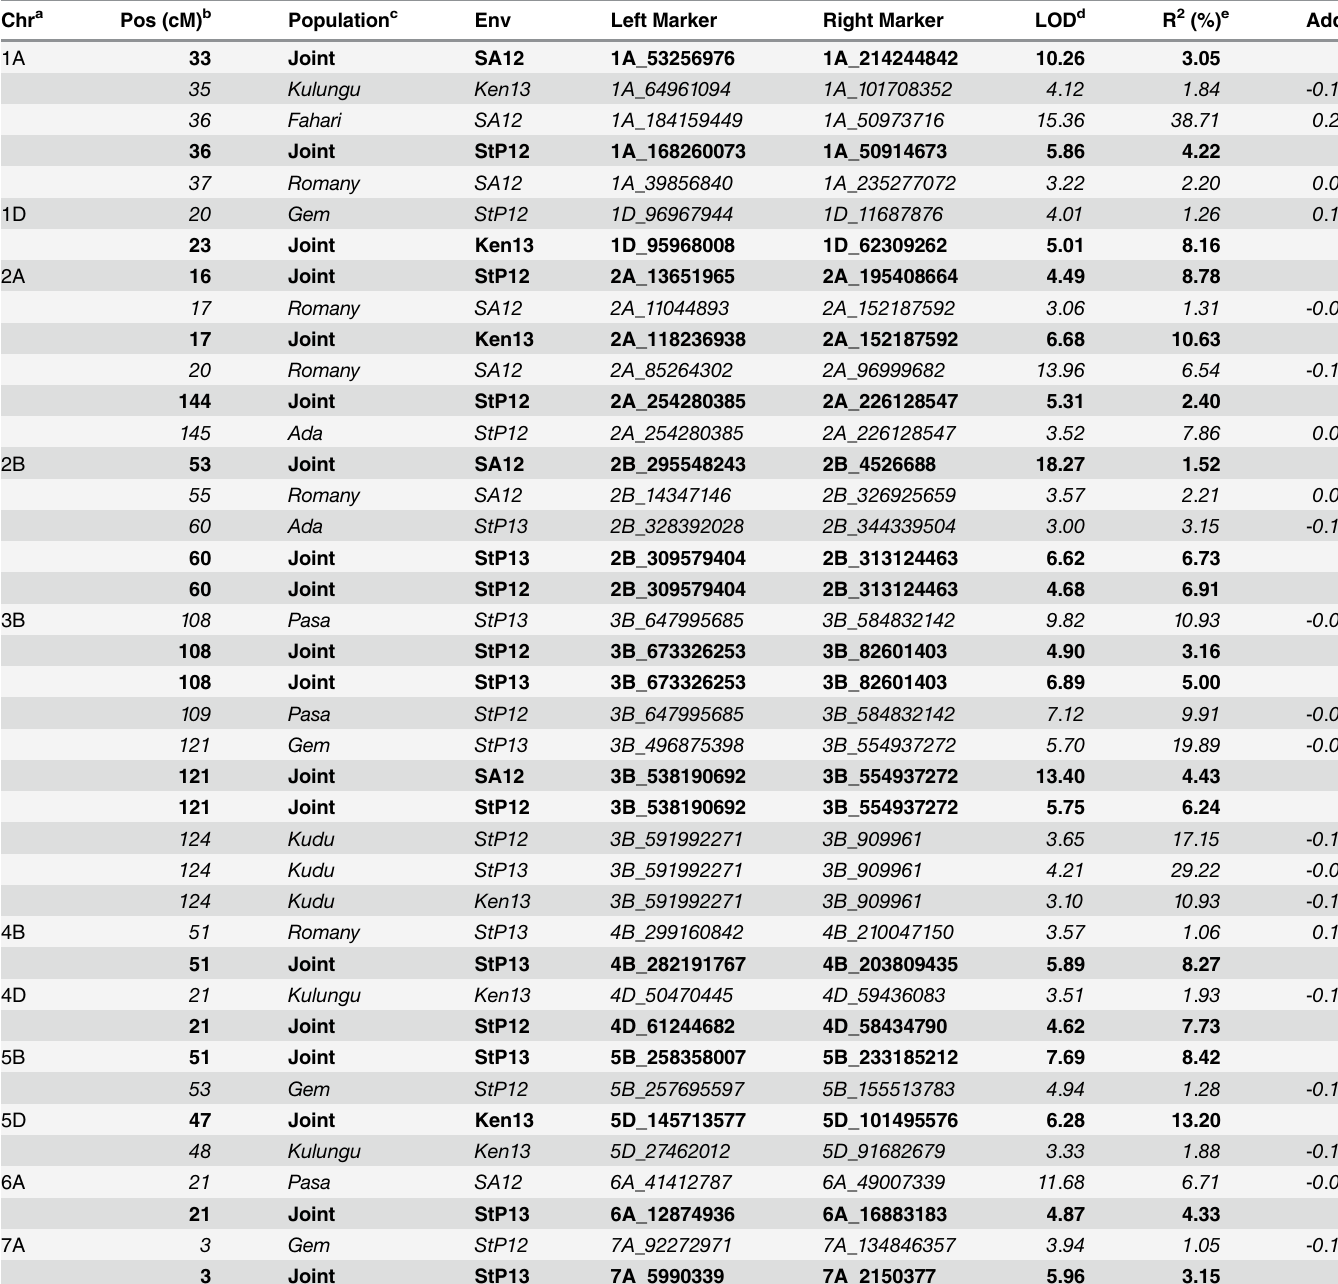
Table 2. Common quantitative trait loci (QTL) detected between the joint inclusive composite interval mapping (JICIM) in nested association map- ping of 10 RIL populations, and inclusive composite interval mapping (ICIM) methods in individual populations for stem rust adult plant resistance in four